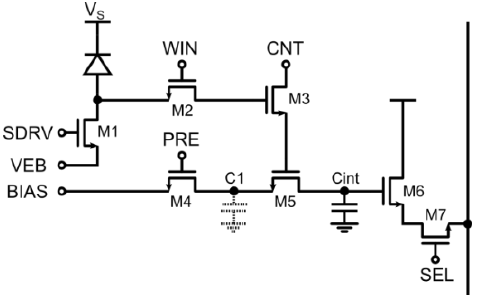
Figure 8. Analog time-gated pixel with transistor reuse and deferred analog counting [36].